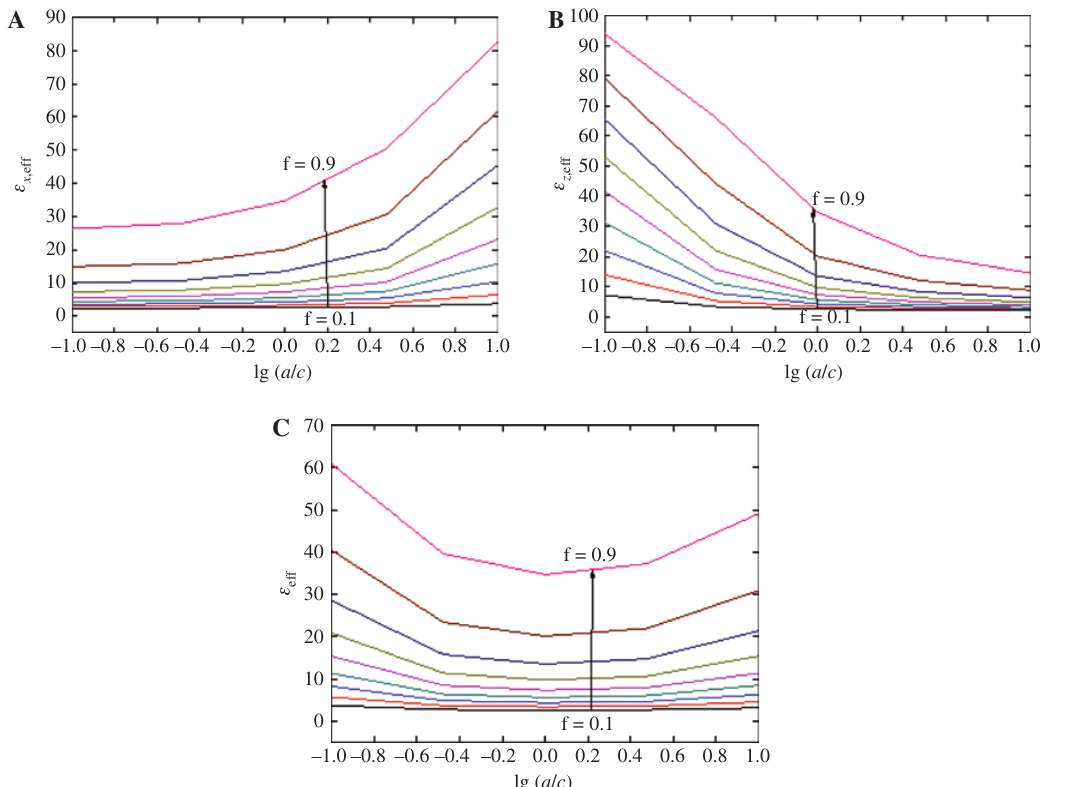
Figure 6: The effective permittivity of a mixture with aligned bilayer ellipsoids in the x or y direction (A) and z direction (B), along with that of a mixture with bilayer ellipsoids oriented randomly (C) for different aspect ratios.